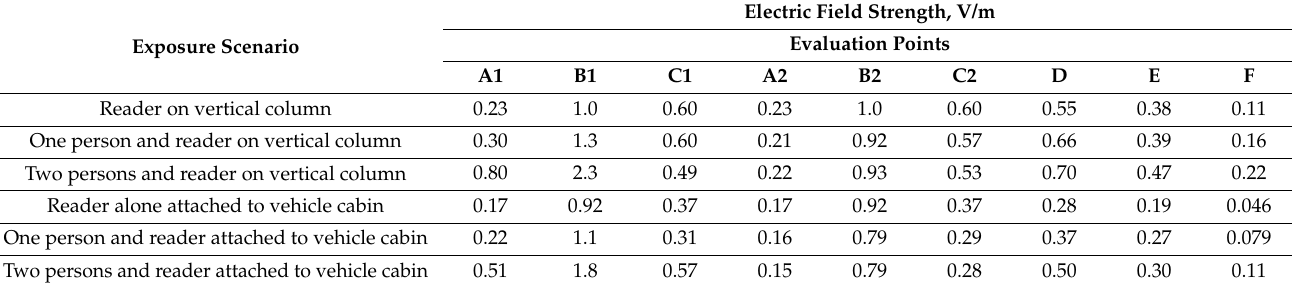
Table 2. Electric field strength values in various exposure scenarios near to the HF RFID reader with an internal antenna of inner dimensions of 8 × 8 cm, operating with an output power sufficient for an RR of 10 cm (according to ISO/IEC 14443-2:2020 requirements for PICCs of classes